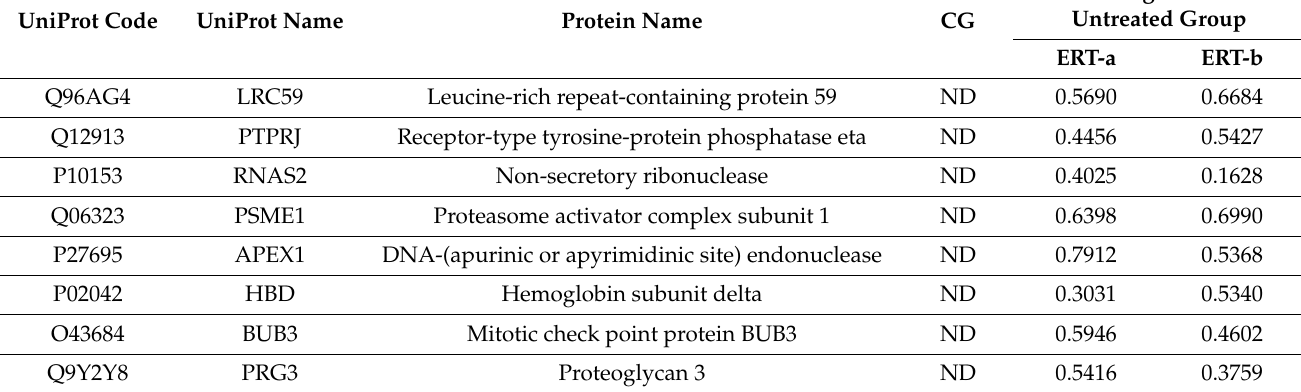
Fold-change values in red indicate proteins that were not significantly dysregulated because the p value was >0.05 ( p > 0.05). Abbreviations: CG, control group; ERT-a: ERT-a, patients sampled before enzyme infusion; ERT-b, patients sampled 24 h after enzyme infusion; MPS IVA, Mucopolysaccharidosis type IVA; ND, not